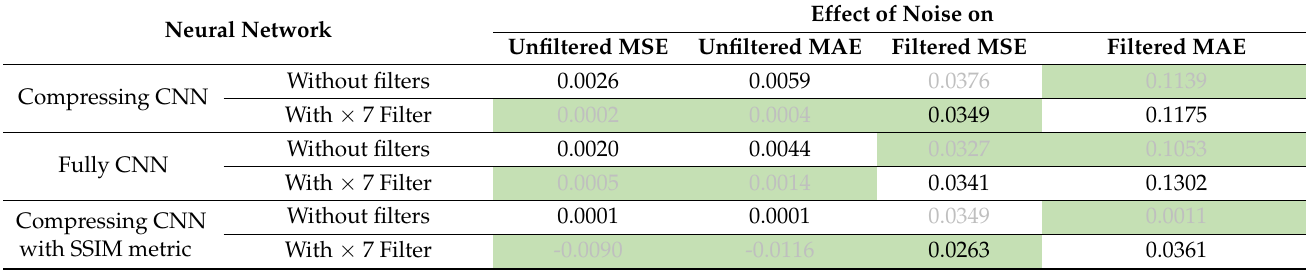
Table 2. Simple analysis of the error change due to noise application. Green background determines the better results, while gray font means that the neural network was not trained for this task.